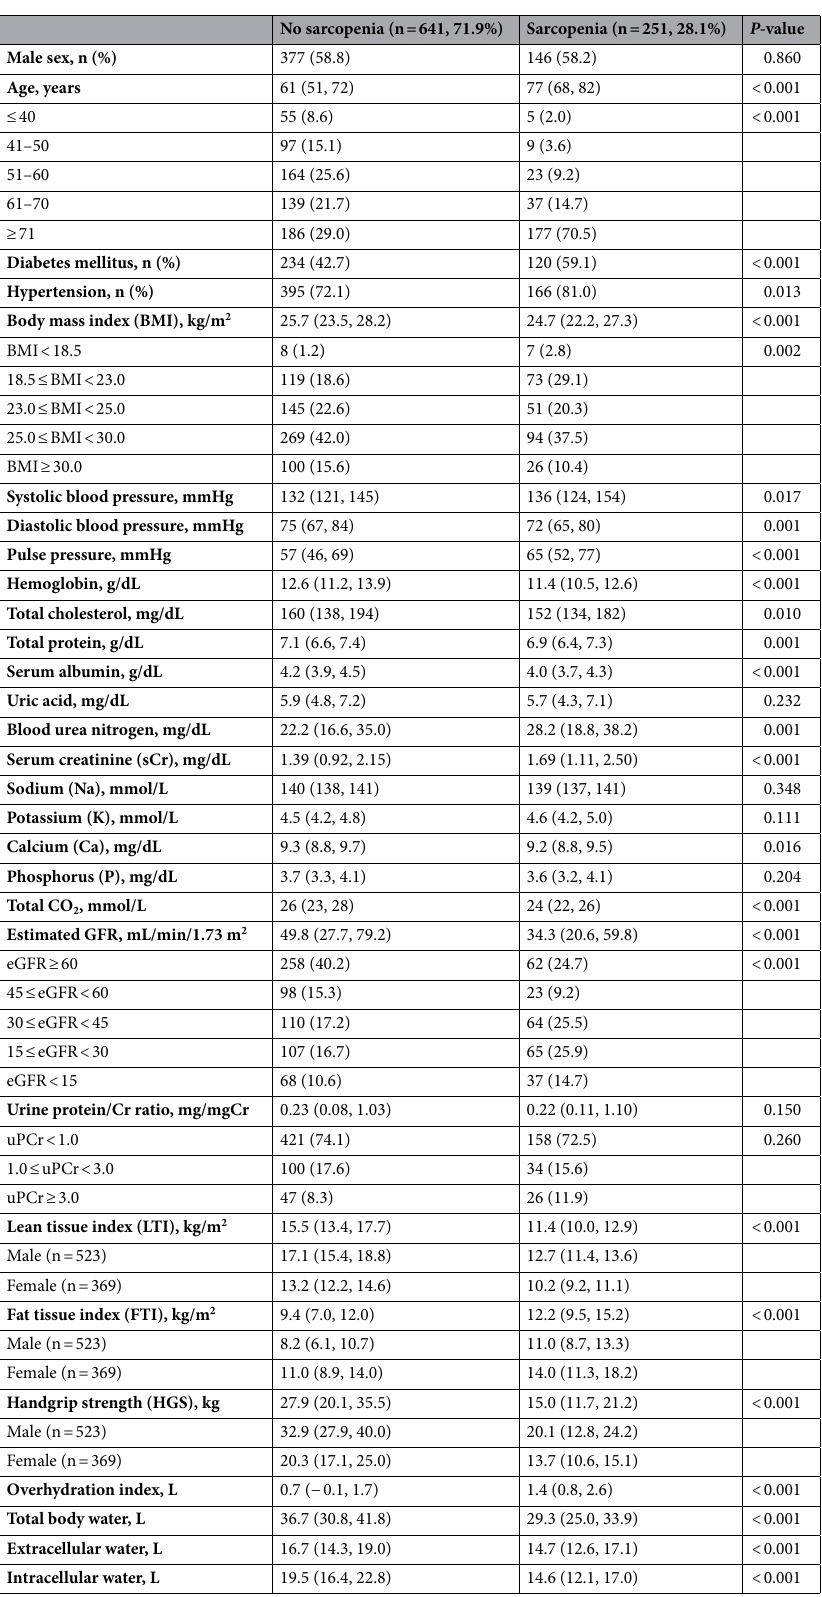
Table 1. Baseline characteristics and demographics according to sarcopenia. The data are expressed as proportion (%), mean ± SD, or median (IQR). GFR, glomerular filtration rate; uPCr, urine protein/Cr